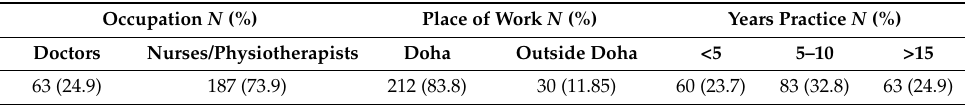
Table 1. Demographic and work-related characteristics of the